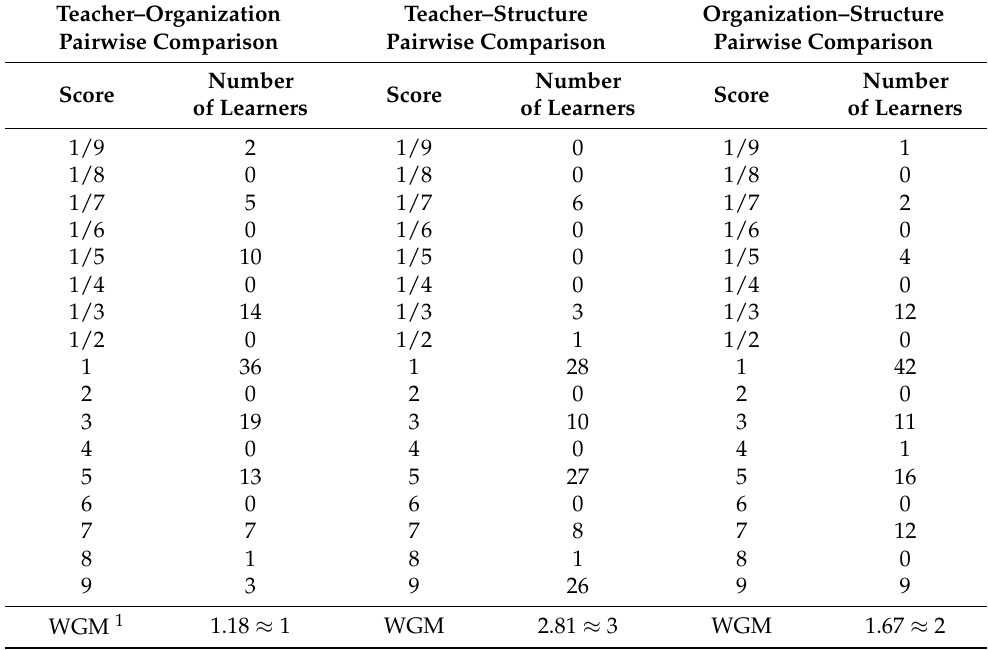
Table 3. Pairwise comparisons between parent